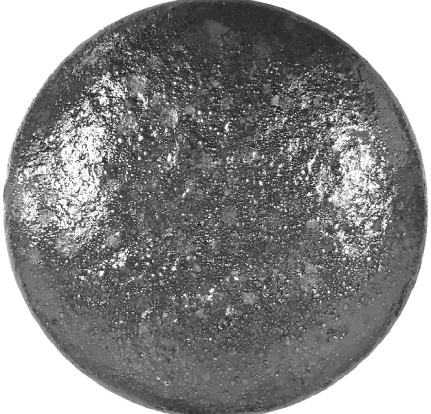
Figure 1: The sample of the prepared CP